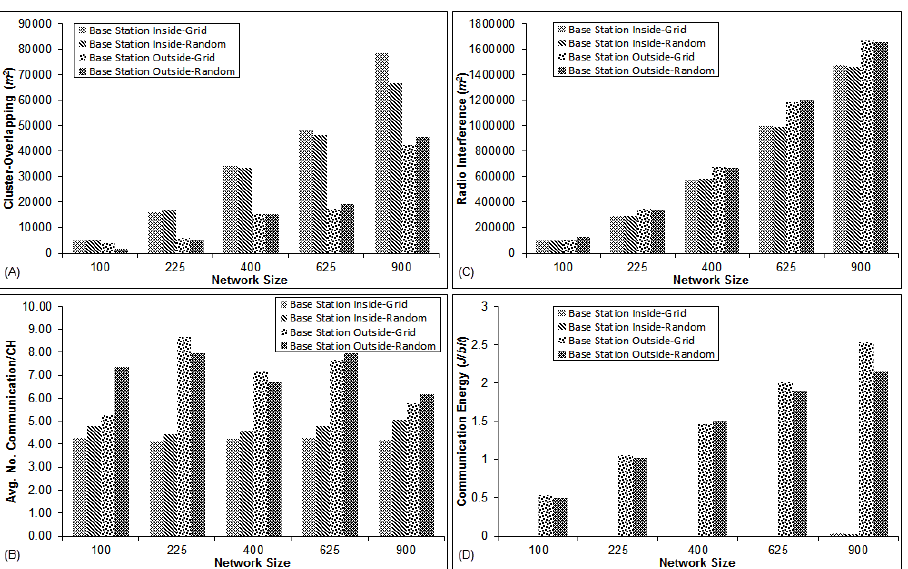
Figure 7. Cluster-overlapping (A), avg. no. of communication/CH (B), radio interference (C), and communication energy (D) versus network sizes for two possible locations of